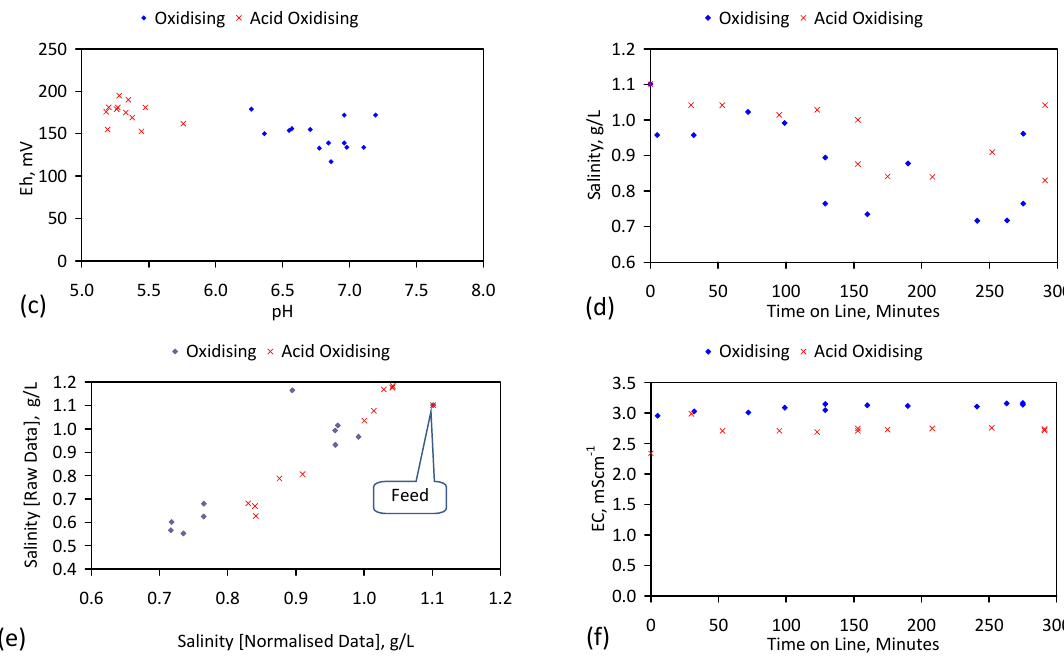
Figure C34. ZVM TPA example Trial E146. 14th Reuse; Operating Temperature: 12–16 °C; Oxidising Environment: Water volume in the reactor = 0.24 m 3 ; ZVM TPA from Trial E145 in a cartridge = 0.4 kg; Air flow = 120 L·h − 1 . Acid Oxidising Environment: Water volume in the reactor = 5.4 L; ZVM TPA from Trial E144 in a cartridge = 0.4 L; Gas flow (80% N 2 + 20% CO 2 ) = 3.3 L·h − 1 . ( a ) Eh vs. time; ( b ) pH vs. time; ( c ) pH vs. Eh; ( d ) Salinity vs. time; ( e ) Salinity calculated from normalised data vs. salinity calculated from raw data; ( f ) EC vs. time.